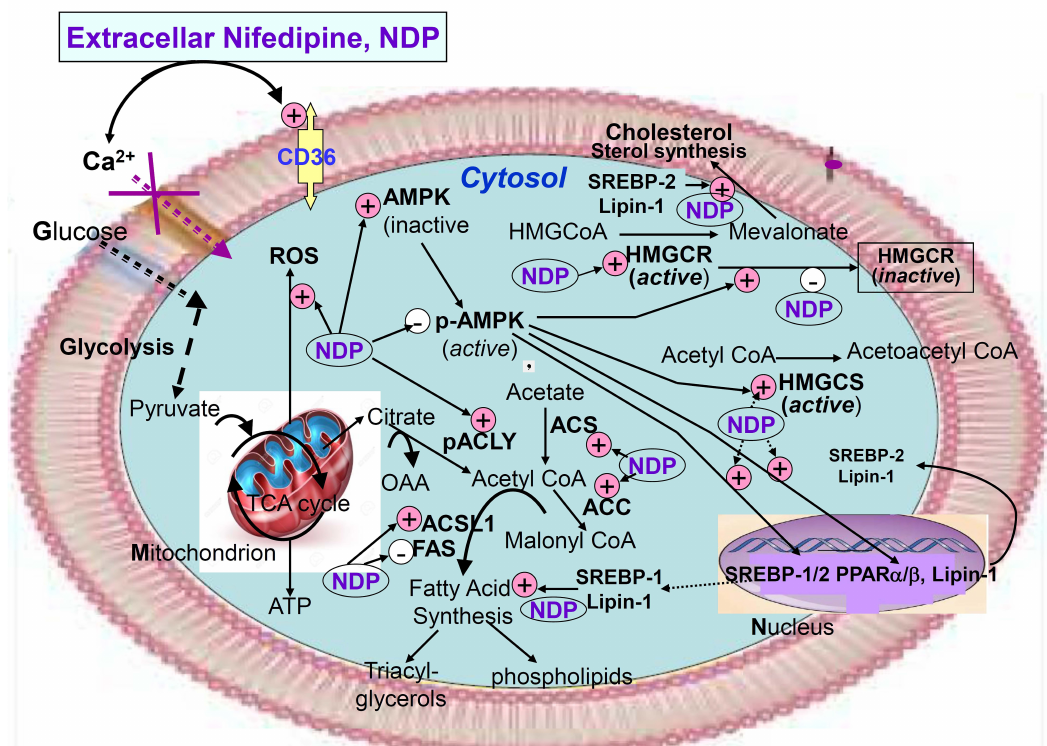
Figure 7. Graphic summary for nifedipine-induced lipogenesis on renal tubular cell. In this study, nifedipine upregulated CD36 membrane protein and ROS, but decreased the active form of p-AMPK. Further, de novo cholesterol biosynthesis by activating nuclear transcriptional factor SREBP-1/2, PPAR- α , and lipin-1 [19] were expressed. Specifically and selectively, SREBP-1a activates fatty acid and cholesterol synthesis; SREBP-1c, fatty acid synthesis; and SREBP-2, cholesterol synthesis and uptake. Then, lipogenesis related enzymes ACS, ACC, ACSL1, ACL, and HMGCR were expressed. NDP, non-dihydropyridine; HMGCR, HMG CoA reductase; ACS, acetyl CoA synthetase; ACC, acetyl CoA carboxylase; ACSL1, long chain fatty acyl elongase; FAS, fatty acid synthase; ACL, ATP citrate lyase; PPAR- α , peroxisome proliferator-activated receptor- α ; SREBP1/2, Sterol regulatory element-binding proteins